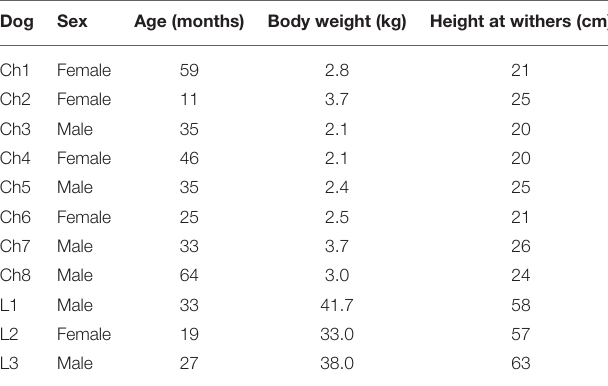
TABLE 1 | Details of the study population: Chihuahuas (Ch), Labrador retrievers (L). Dog